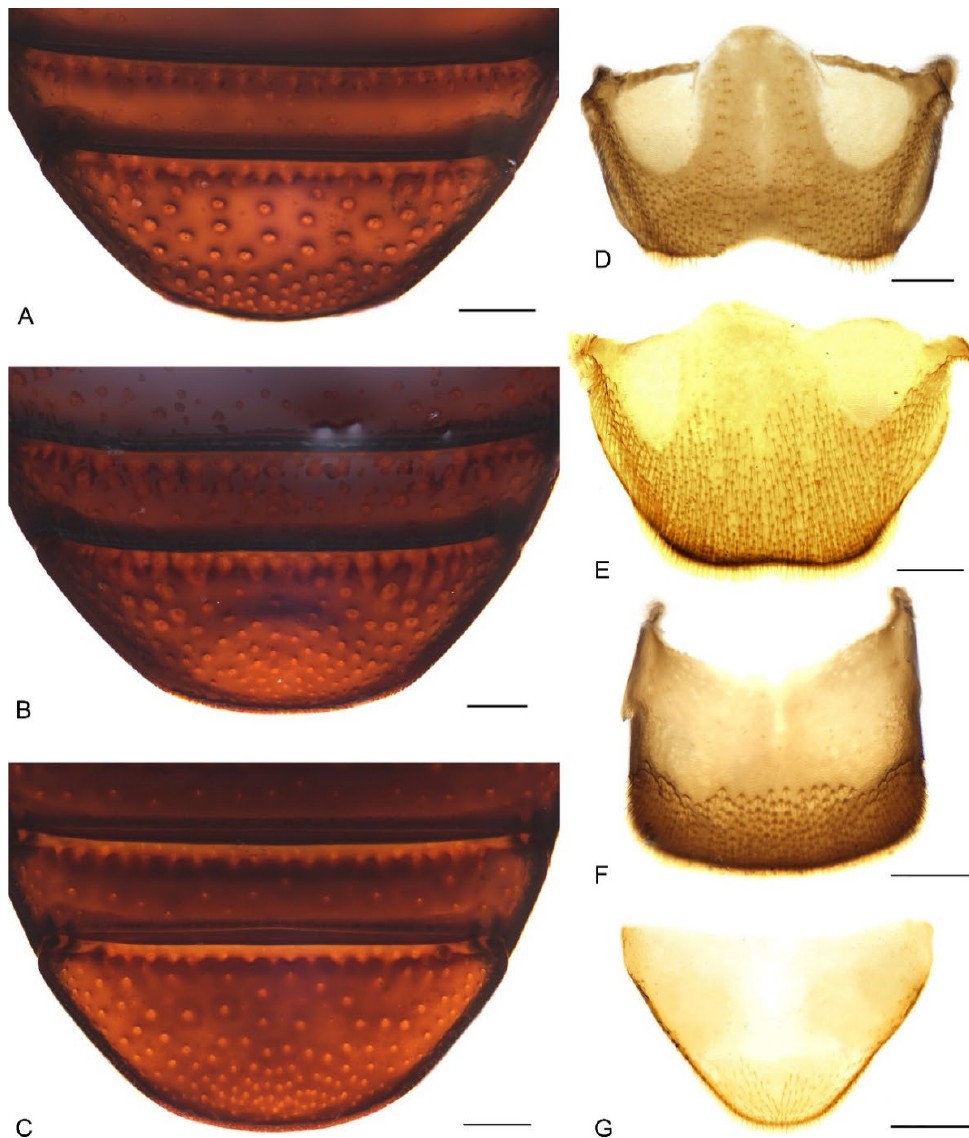
Figure 7. Diagnostic external characters and terminalia of Miltotranes : ( A ) M. prosternalis , abdominal ventrite 5 of female, ventral view; ( B ) M. subopacus , ditto; ( C ) M. wilsoni sp. n., ditto; ( D ) M. prosternalis , tergite VII of male, dorsal view; ( E ) ditto, female; ( F ) ditto, tergite VIII of male, dorsal view; ( G ) ditto, female. Scale bars: 0.2 mm.